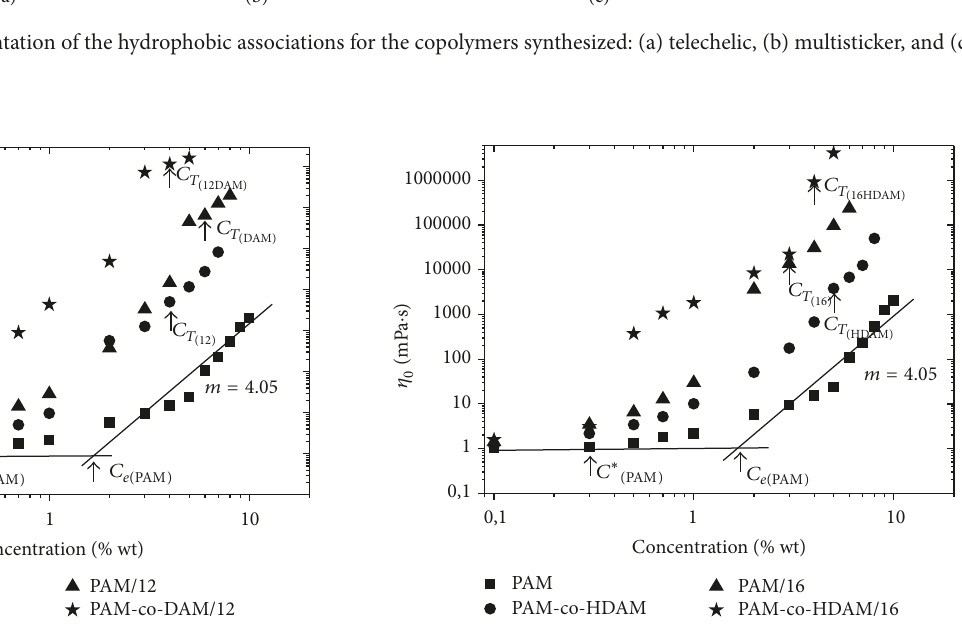
Figure 14: Variation of zero-shear viscosity ( 𝜂 0 ) as a function of polymer concentration ( 𝐶 ), for the synthesized polymers using the linear C16 hydrophobic